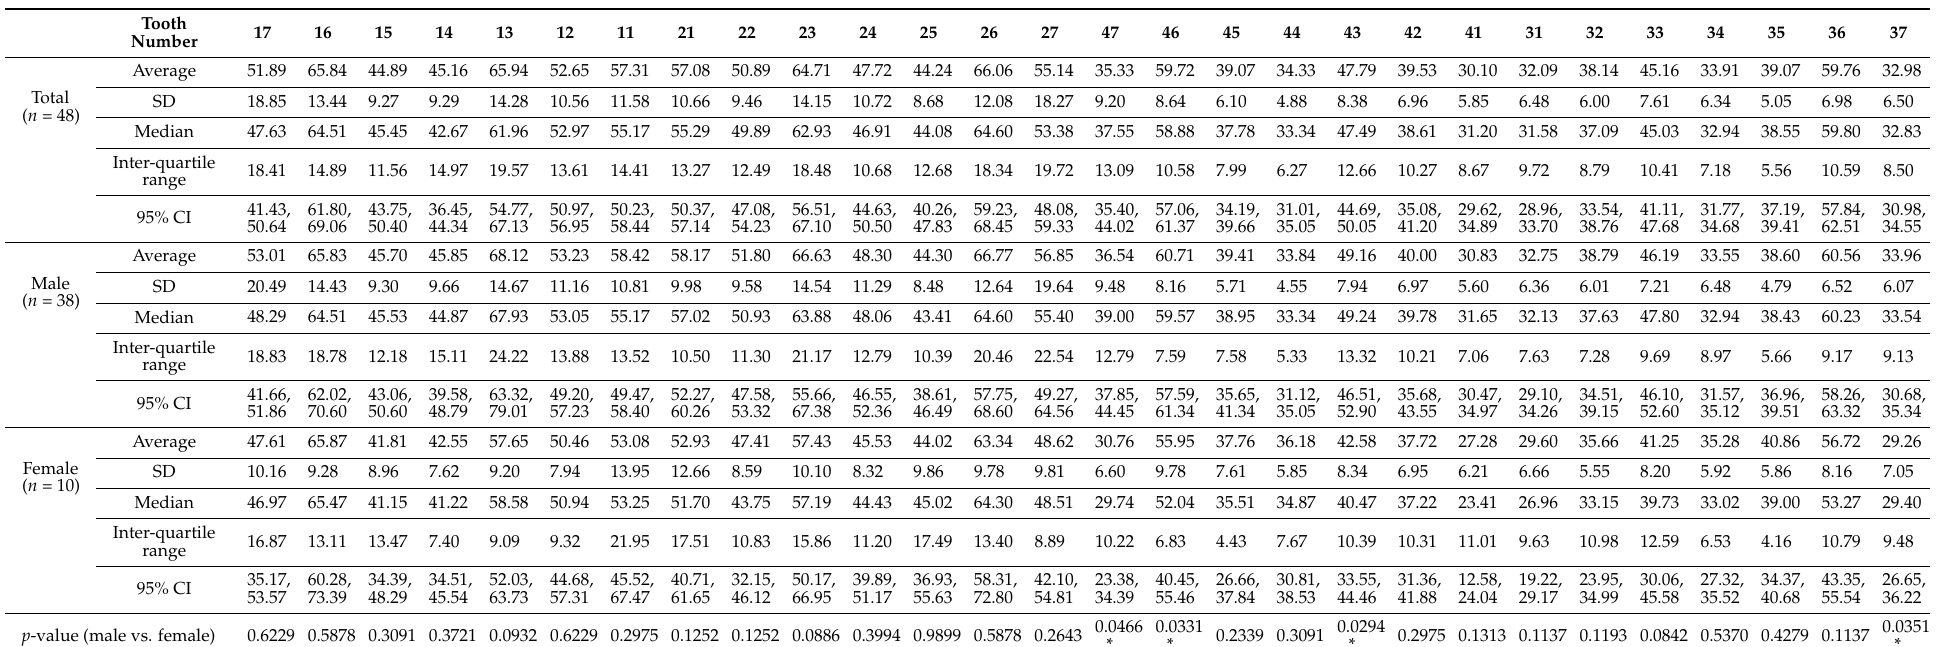
Table A3. Area of the keratinized gingiva (in mm 2 ).